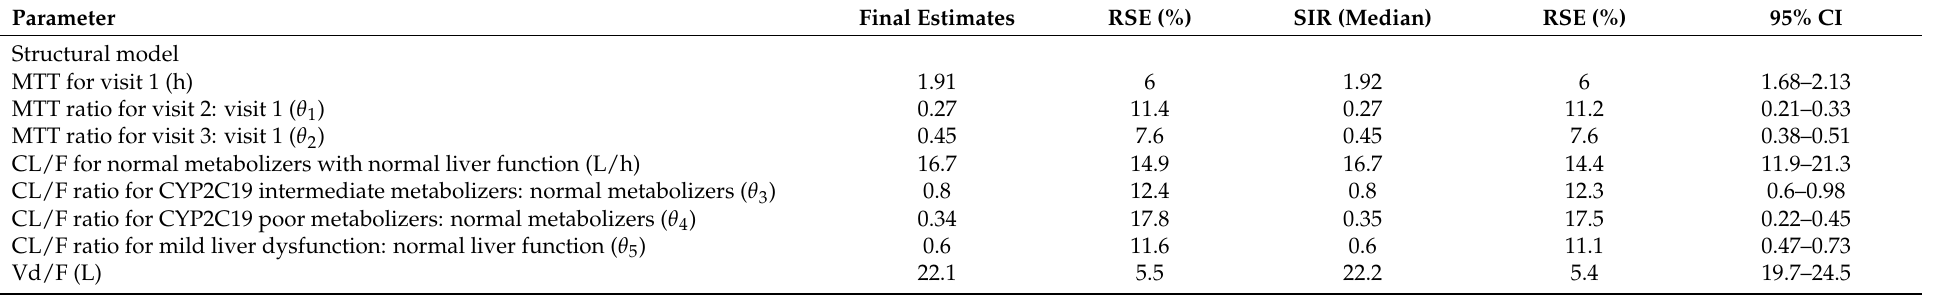
Figure 2. Prediction-corrected visual predictive check of the final model at each visit. Observed concentrations are indicated by black open circles, and the dotted and solid lines represent the 10th, 50th, and 90th percentiles of the observed data. The shaded areas represent 95% confidence intervals for the corresponding percentiles of simulated data. Table 2. Population pharmacokinetic parameter estimates for the final model and the SIR